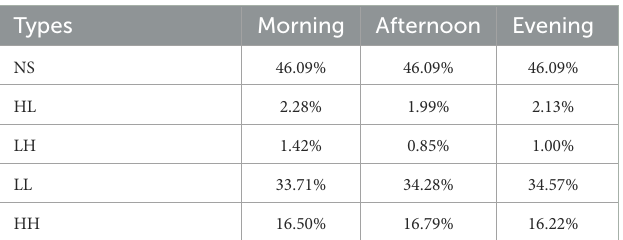
TABLE 3 Proportions of different matching types of environmental comfort and urban